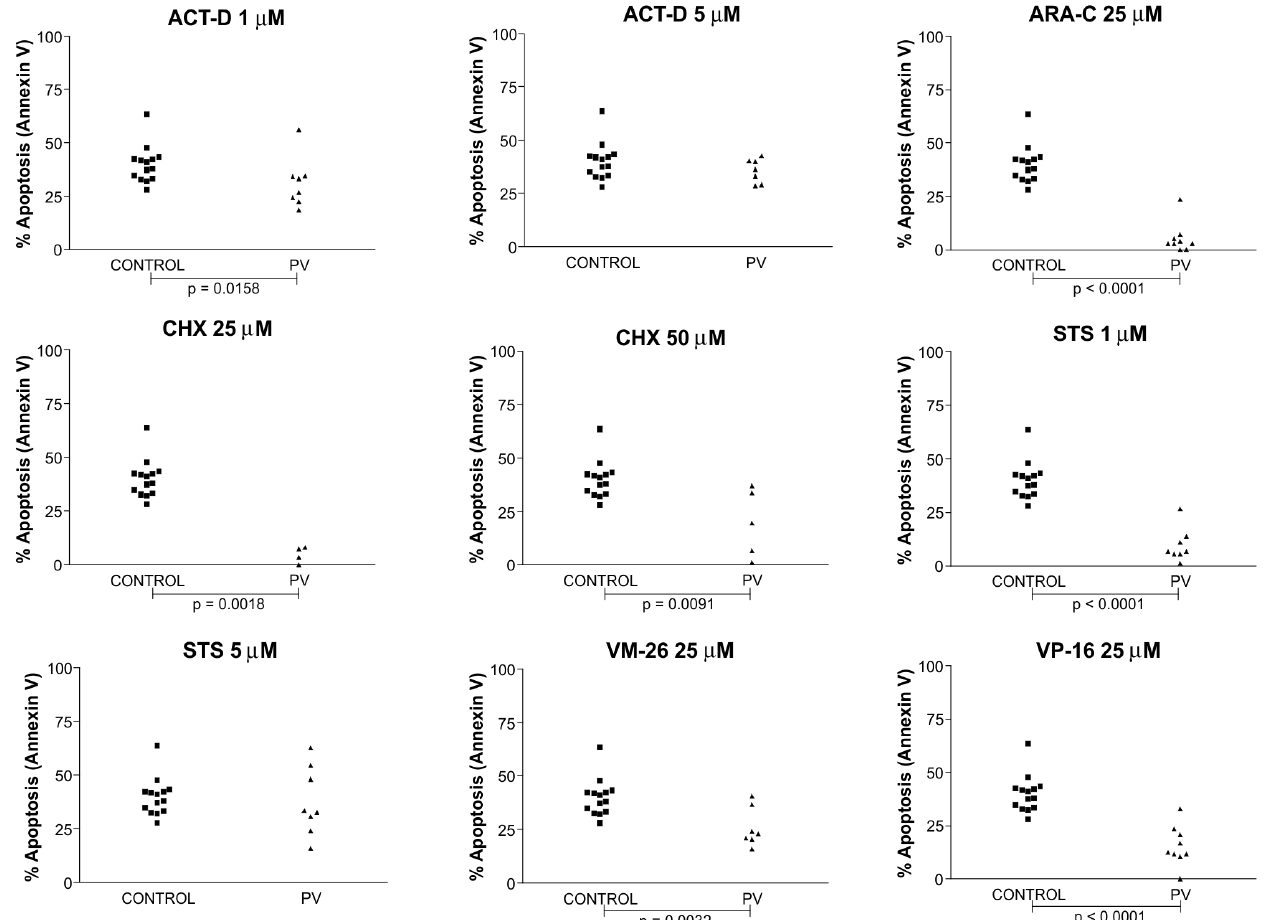
FIGURE 3 - Percentage of mononuclear cell apoptosis induced by drugs in the PV and control groups. Patient’s mononuclear cells were more resistant to ACT-D 1 µM (p=0.015), CHX 25 m M and 50 m M (p=0.002 and 0.001), STS 1 µM (p<0.001), cytarabine 25 µM (p<0.001), teniposide 25 µM (p<0.003), and etoposide 25 µM (p<0.001) than controls’ mononuclear